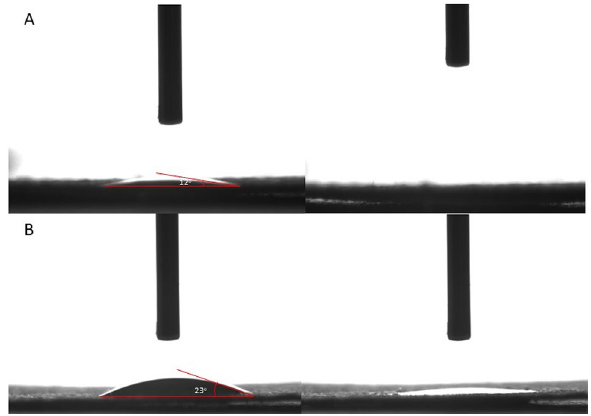
Figure 10. The profile of a water droplet on the surface of: cellulose fabric consisting of pure cellulose fibers ( A ), cellulose fibers functionalized with 3 wt% of ZnO structures ( B